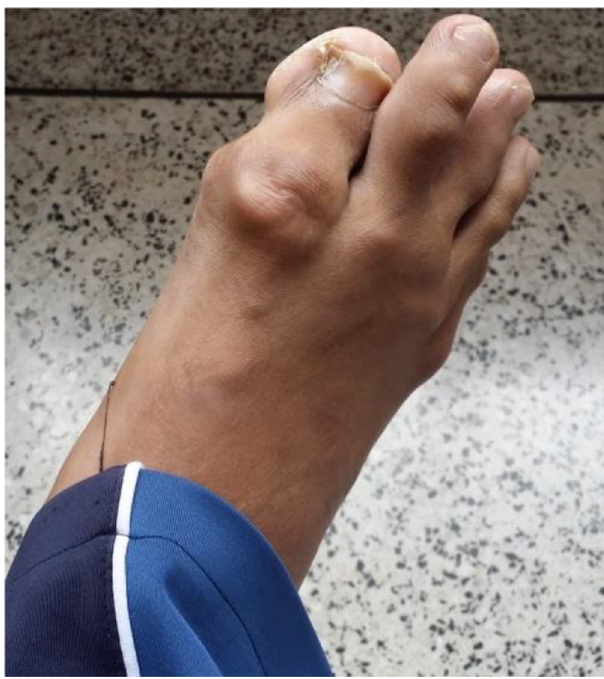
Fig. 1. Laterodeviation of the hallux.